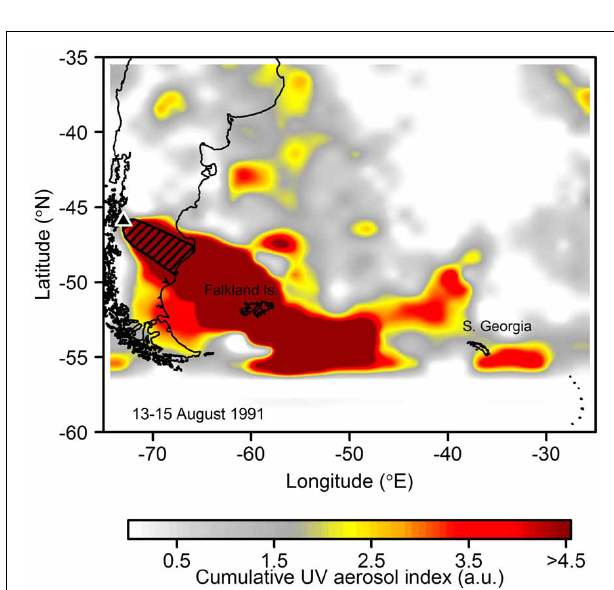
eruption. Gray lines on the main figure and (B,C) correspond to the carbon export that would produce (i) the observed O 2 pulse from southern hemisphere oceans in 1991/1992 subsequent to the Hudson and Pinatubo events (Keeling et al., 1996) (dark gray); and (ii) the extrapolated surface ocean dissolved pCO 2 reduction at Ocean Station Papa subsequent to the Kasatochi event (Hamme et al., 2010) (light gray). Black dots on the Kasatochi curve correspond to upper and lower Fe release bounds measured from Kasatochi ash by Olgun et al. (2013b) (reported as 61–83nmol Fe (g ash) − 1 ).